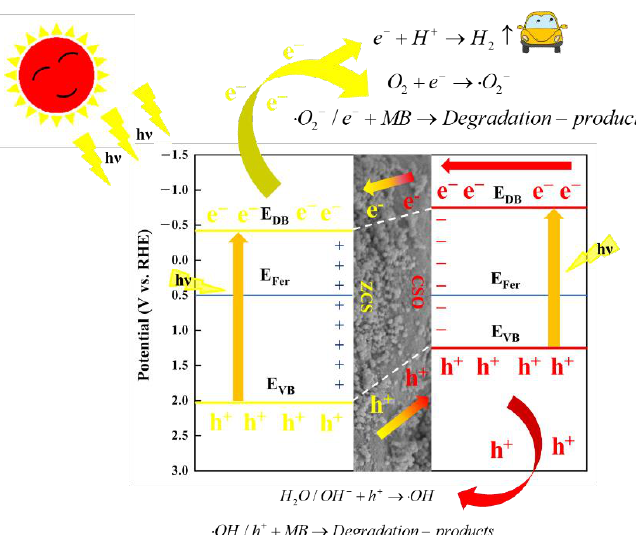
Figure 15. The photocatalytic mechanism diagram of the ZCS and CSO composite photocatalyst.